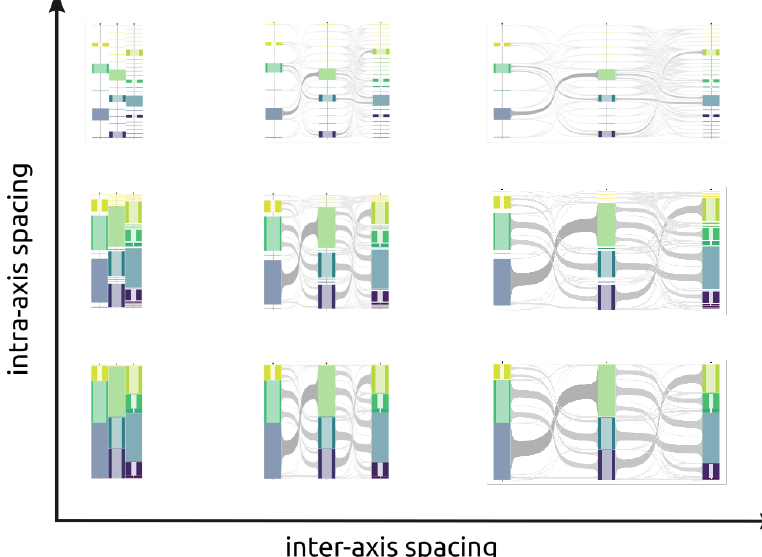
Figure 6. The modification of the two spacings, inter- and intra-axis, allows to tune the representation to get the best ratio depending on the user interest. Thus, we can go from no spaces at all, providing a stacked-histogram (bottom left), to a representation that rather focuses on relative distance between clusters and elements distribution between axes (top